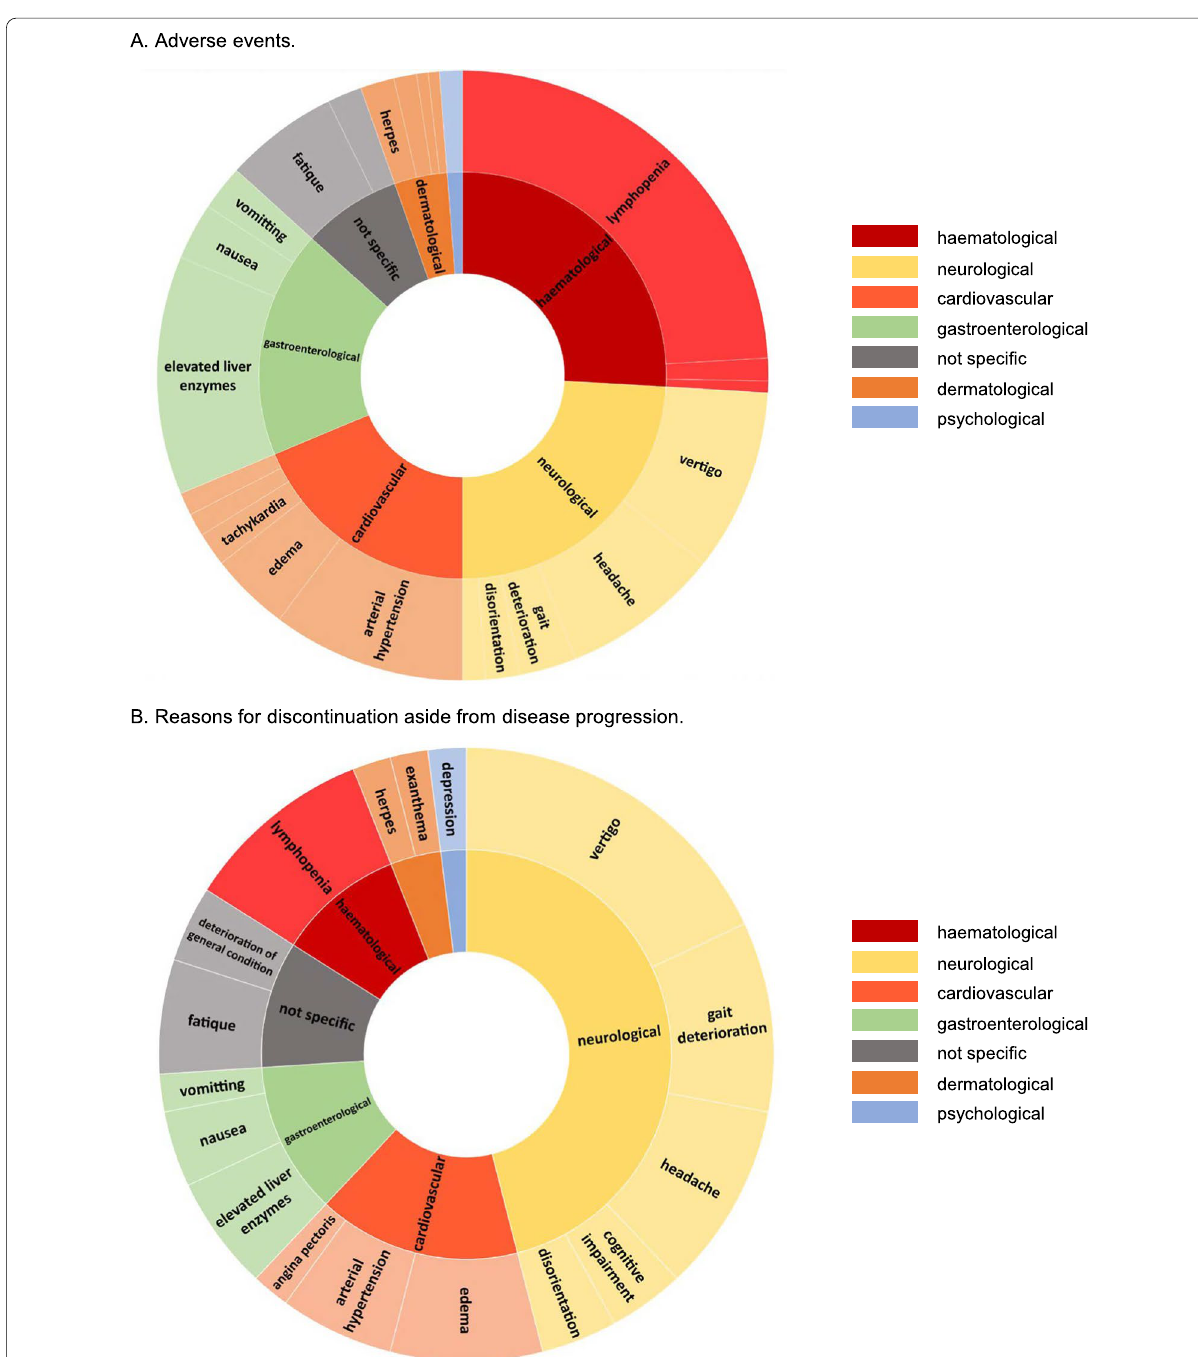
Fig. 5 Adverse event (AE) profile and reasons for discontinuation. Part A AE occured in 46.0% of patients, with lymphopenia being the most common (38.1%). This was followed by elevated liver enzymes (20.0%) and arterial hypertension (16.2%). Part B The most common AE being a reason for discontinuation was vertigo (15.2%). When comparing AE in general and AE that led to discontinuation, a different distribution was observed. While hematological AE were the most common group in general AE, AE that manifested as neurological symptoms were the most common AE that led to discontinuation of therapy. AE, adverse